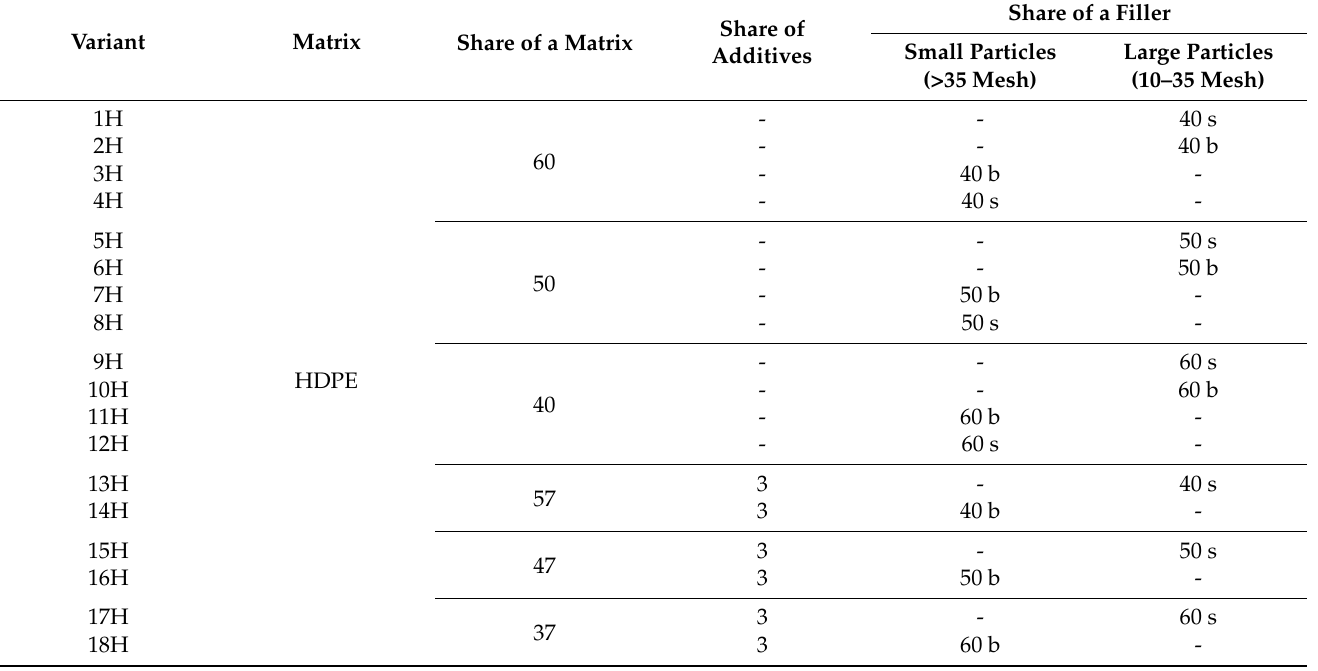
Table 2. HDPE-based composites